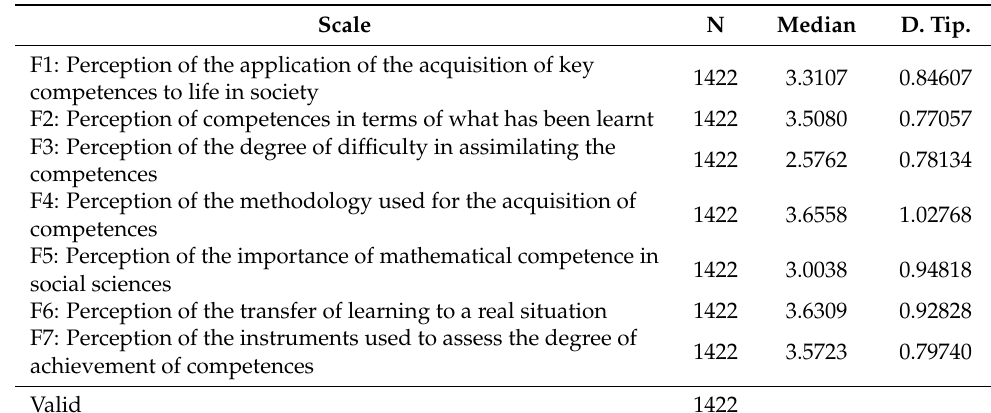
Table 2. Descriptive statistics of the